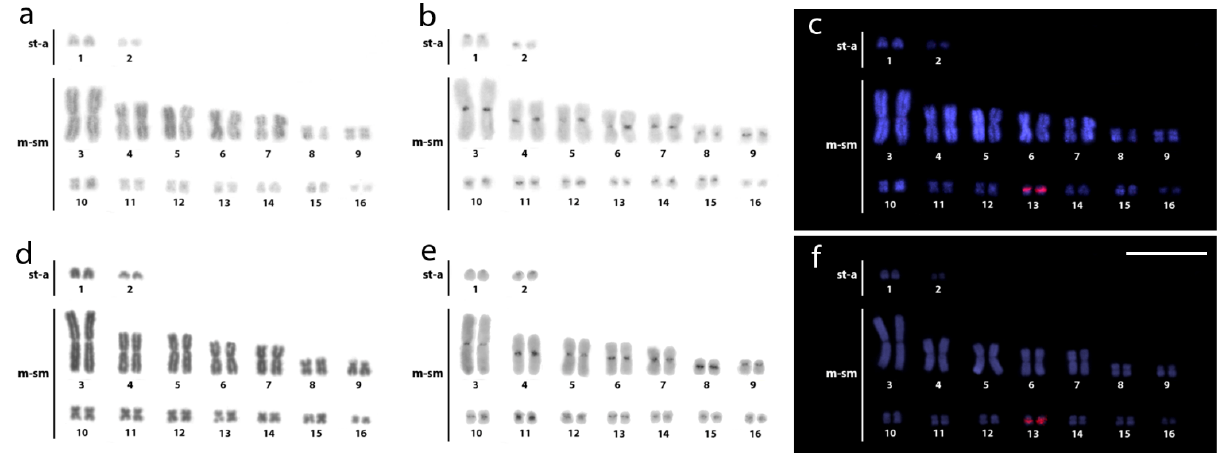
Figure 2. Female karyotypes of Caiman crocodilus ( a – c ), C. latirostris ( d – f ), C. yacare ( g – i ), Melanosuchus niger ( j – l ), Paleosuchus palpebrosus ( m – o ) and P. trigonatus ( p – r ) arranged after inverted-DAPI staining ( a , d , g , j , m , p ), C-banding ( b , e , h , k , n , q ) and FISH with 18S rDNA (red) probe ( c , f , i , l , o , r ). Bar = 20 µm.